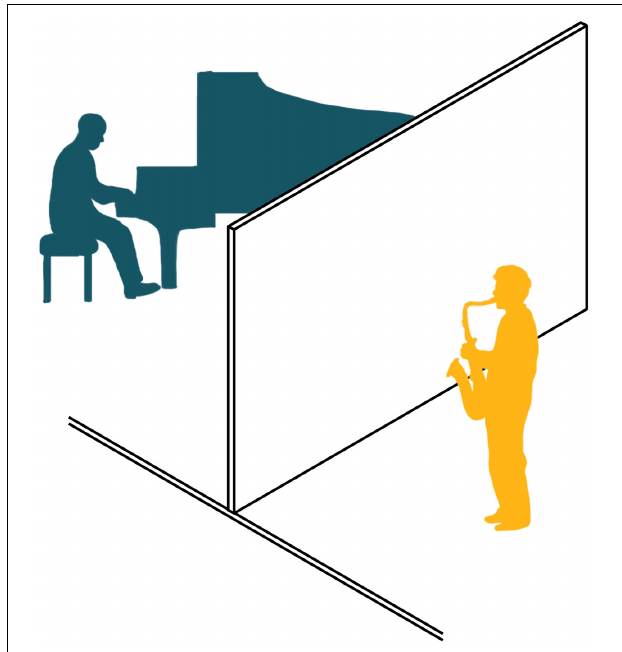
FIGURE 2 | Positioning of pianist and sax player, on either side of a screen onstage in the performance